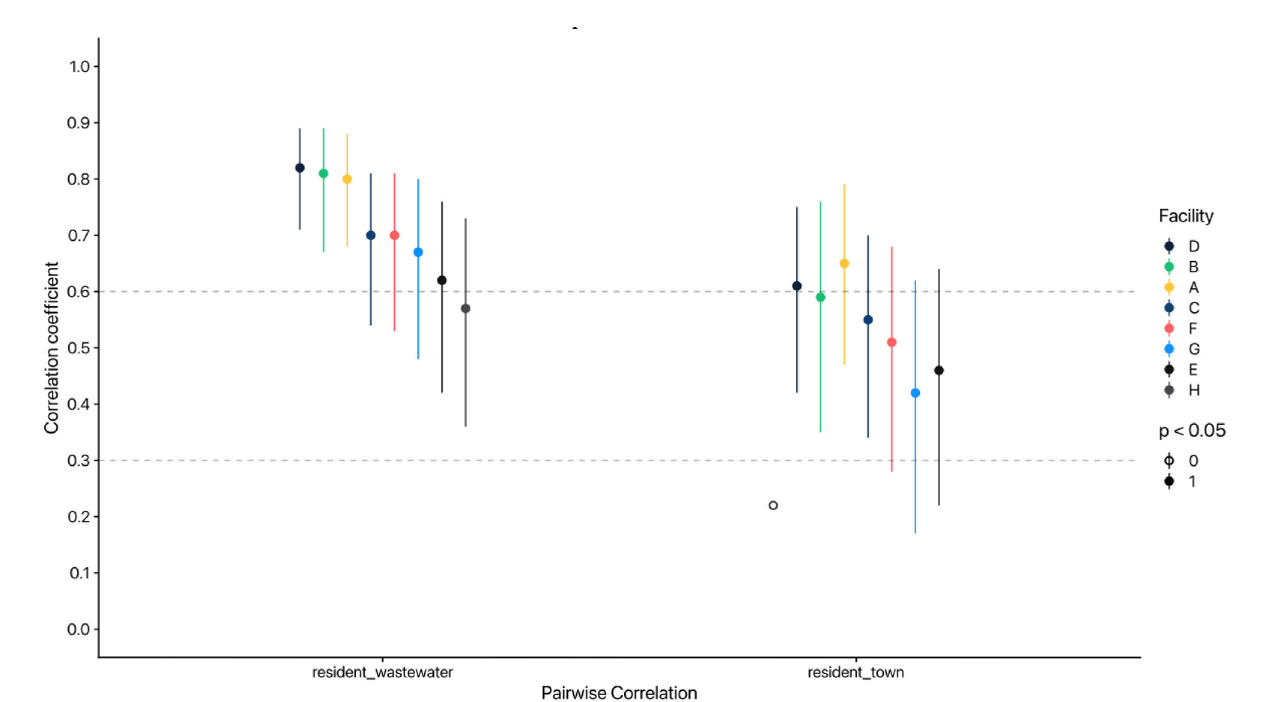
FIGURE1 Pairwise correlations by resident and town cases and SARS-CoV-2 concentration in wastewater across Massachusetts Department of Corrections facilities. Spearman’s rank correlation coefficient used; lines represent 95% confidence intervals. Case counts and wastewater SARS-CoV-2 virus concentrations were averaged by MMWR week. wastewater = weekly geometric mean of SARS-CoV-2 effective concentrations in copies/L; town = weekly average reported COVID-19 cases by neighboring town; resident = weekly average reported active COVID-19 cases among residents in Mass DOC facilities.